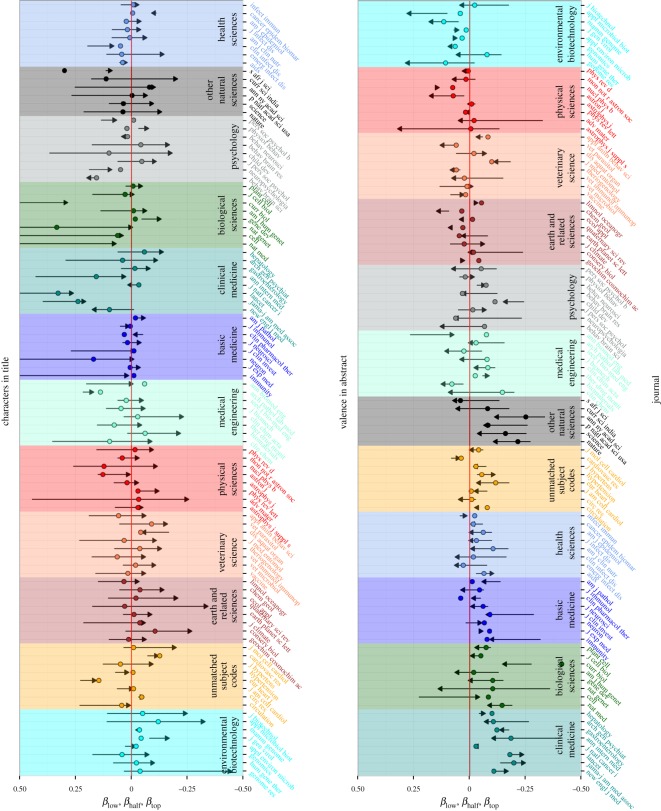
Summary pointers show βlow, βhalf and βtop for two factors: number of title characters (top) and valence in abstract (bottom) (see figure 1 for the definition of summary pointers). Journals are grouped according to the OECD bibliographic categories (see footnote 3). The eight journals with highest IF in each category are shown (six for other natural sciences). The categories are sorted with respect to the number of positive βhalf values. Testing null hypothesis that categories are randomly attributed to journals (we compare the average standard deviation within categories with a random attribution of categories to journals) yields p-values p=0.002 for title length and p<10−8 for valence in abstract. The same procedure performed for IF (by creating 12 categories according to decreasing IF) gives p=0.02 for title length and p<10−5 for valence in abstract, suggesting higher impact exerted by scientific category.